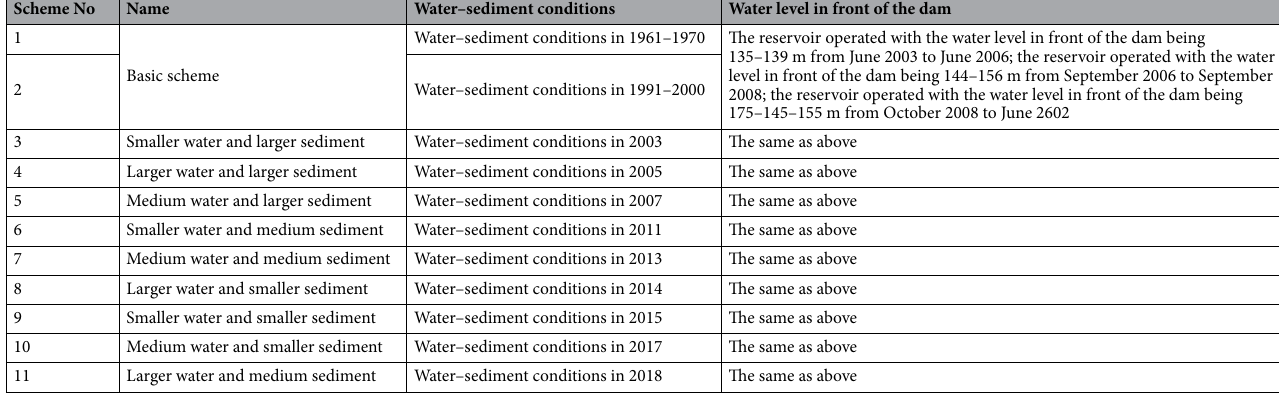
Table 8. Computational conditions of the different